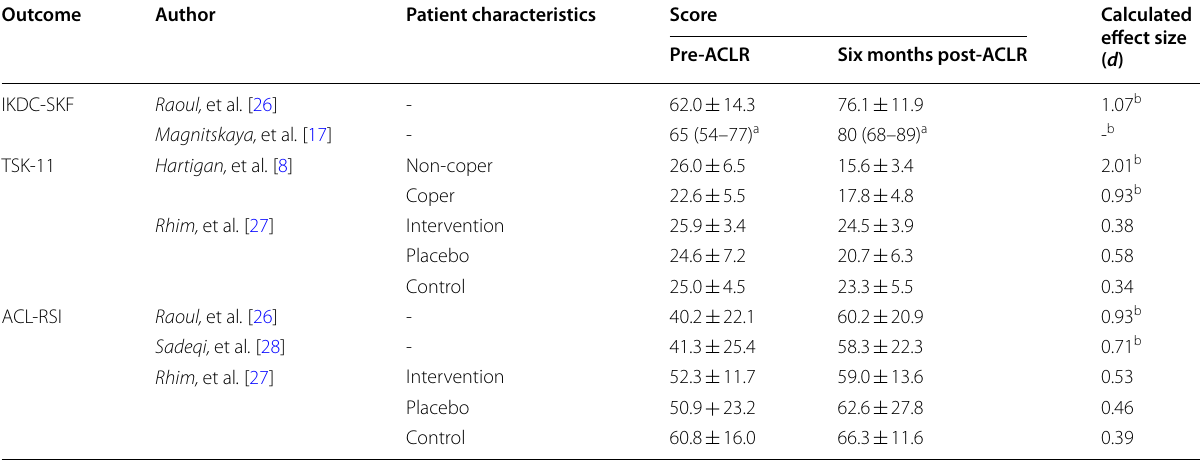
Mean standard deviation, a median (interquartile range), b P < .05 ± ACLR Anterior cruciate ligament reconstruction, IKDC-SKF International Knee Documentation Committee Subjective Knee Form, TSK-11 Tampa Scale for Kinesiophobia-11, ACL-RSI Anterior Cruciate Ligament-Return to Sport after Injury scale